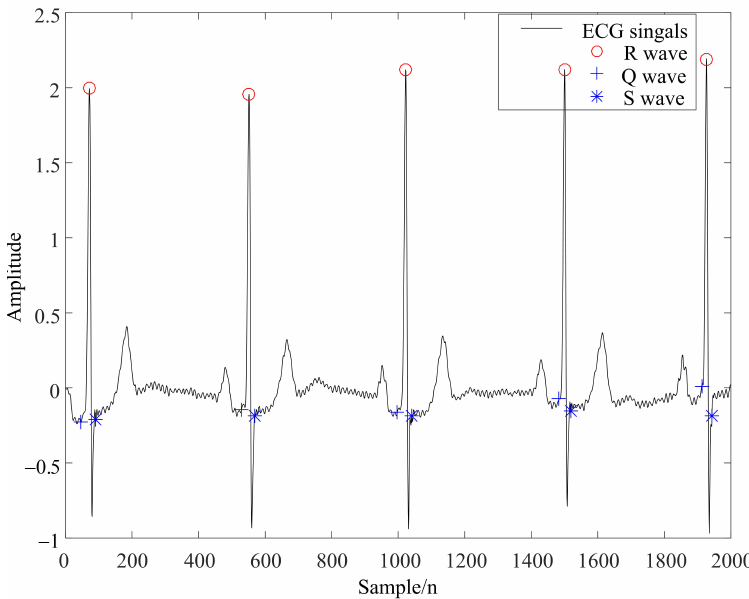
Figure 7. QRS complex extraction results from ECG signals of subject 123 (MIT-BIH arrhythmia